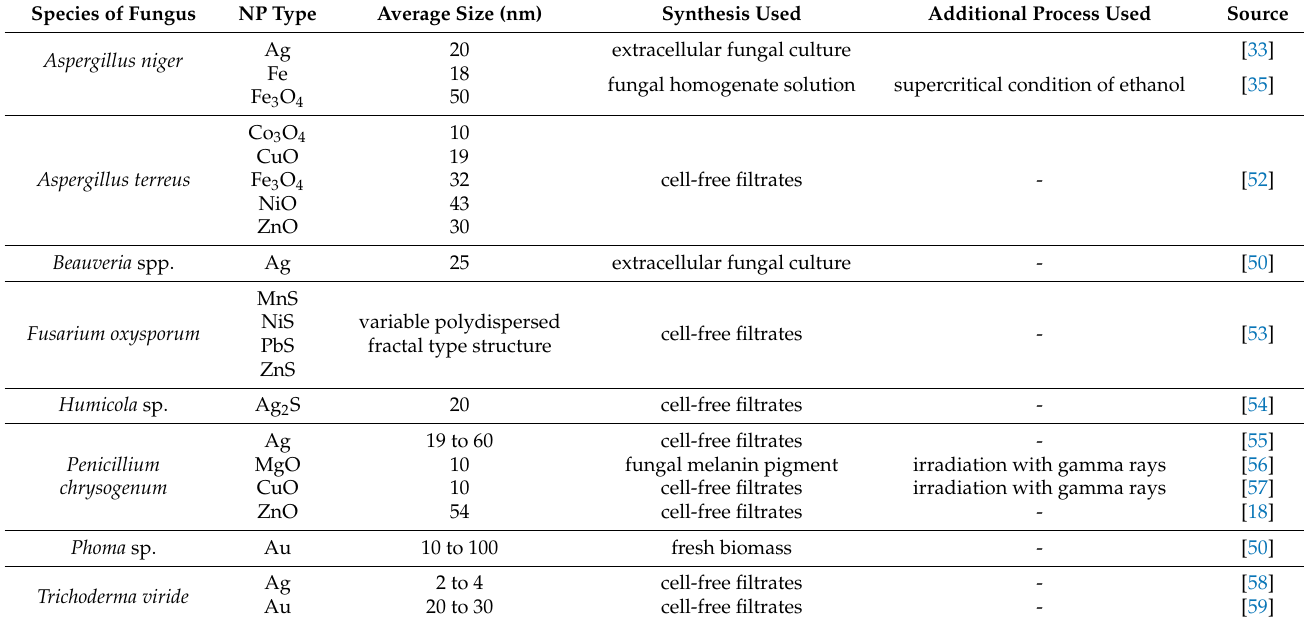
Table 2. Selected examples of ascomycetes used in the synthesis of various metal-containing